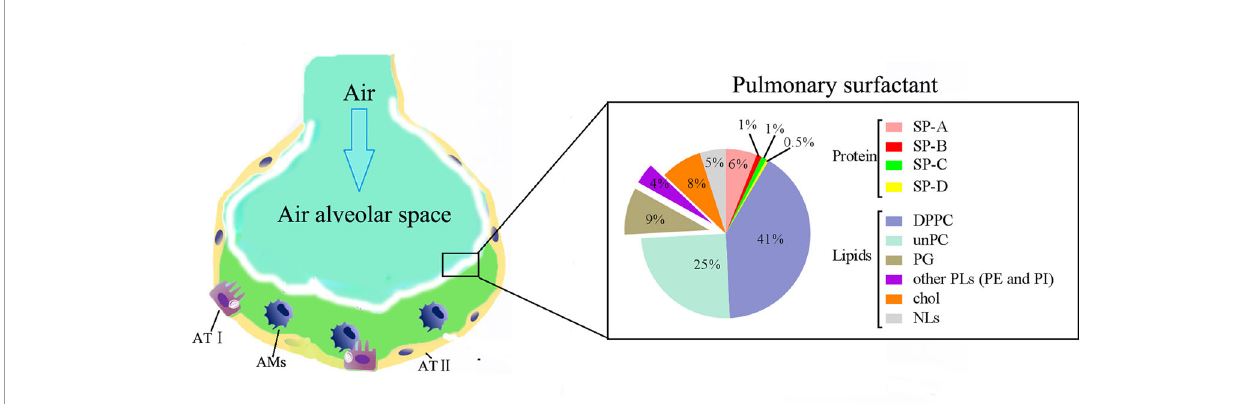
FIGURE 1 | Pulmonary surfactant lipid constituents. Pulmonary surfactant components are important lipoprotein complexes of the lung lining, consisting of 90% lipids and 10% proteins by weight. Pulmonary surfactant proteins contain four proteins, including surfactant protein (SP)-A, SP-B, SP-C, and SP-D. In pulmonary surfactant lipids, the most abundant constituents are glycerophospholipids. Surfactant phospholipids (PLs) account for 80 – 85% of pulmonary surfactant lipids; surfactant PLs are a mixture of lipids, which include phosphatidylcholine (PC, accounting for about 80%), phosphatidylglycerol (PG, accounting for about 7 – 15%), and small quantities (accounting for approximately 5% each) of phosphatidylinositol (PI), phosphatidylethanolamine (PE), and phosphatidylserine (PS). The most prevalent PL in pulmonary surfactant is PC, and approximately 40% of surfactant PC is saturated dipalmitoyl-PC